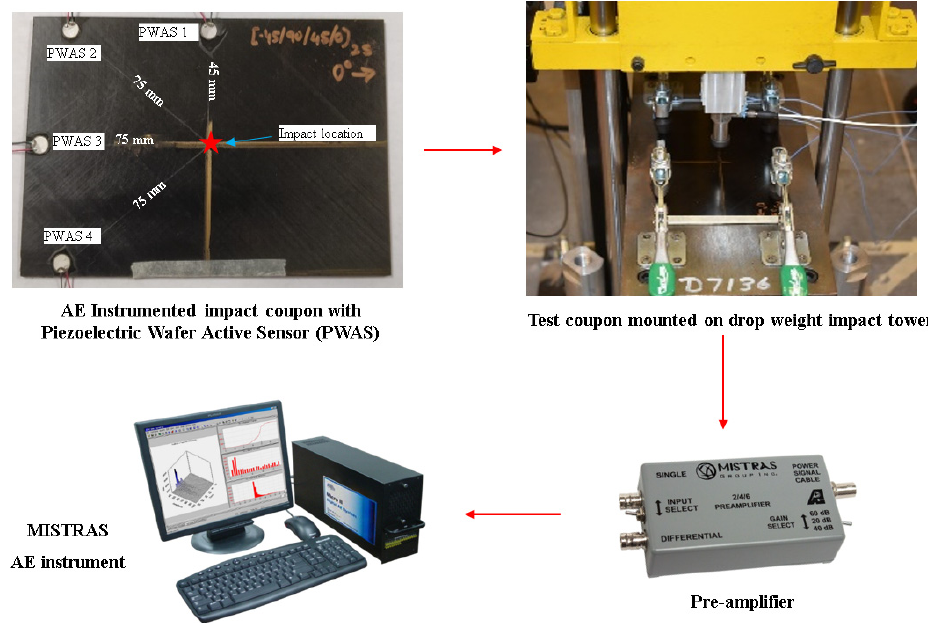
Figure 6. Experimental setup of ASTM drop weight impact test on AE instrumented coupon.